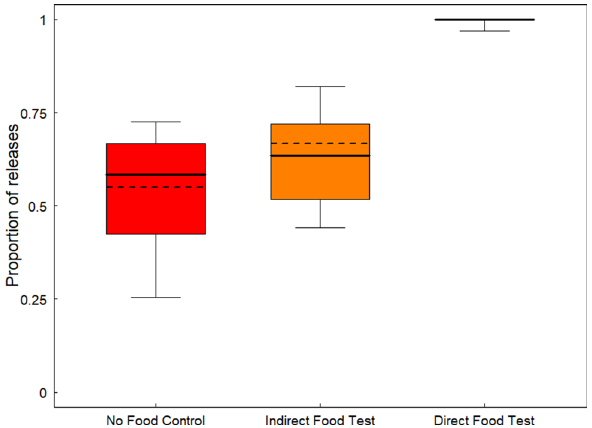
Figure 1. Proportion of trials in which food was released. The box plot represents the median and q1 and q3 quartiles. The dotted line represented the fitted values of the model.